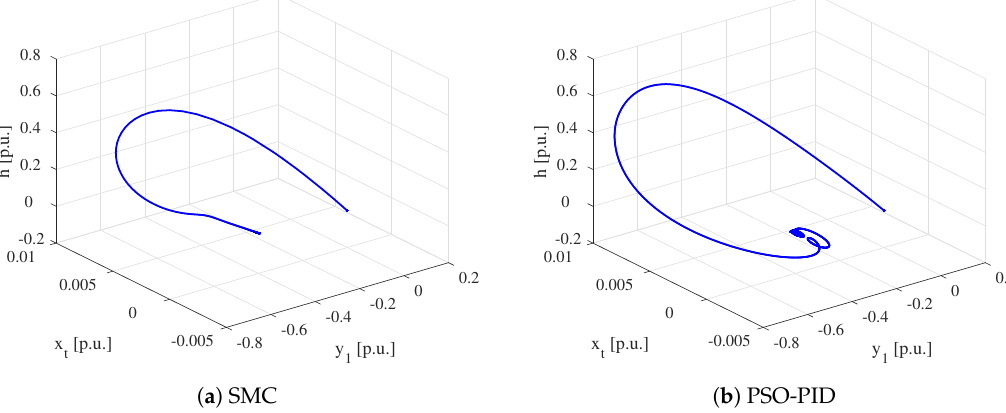
Figure 12. The ternary phase diagrams of y 1 - x t - h regulated by ( a ) SMC and ( b ) PSO-PID under load